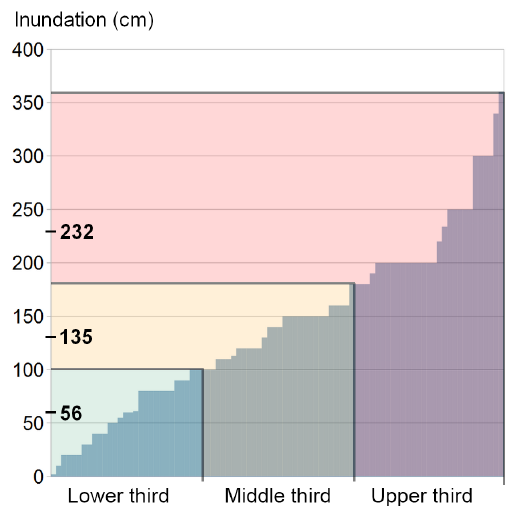
Figure 5. Deriving the local impact indicator. The recorded inun- dation depth is sorted in ascending order. By sorting, the relatively uniform distribution of the inundation values is shown, which al- lows for the general procedure. On the left, the mean values of the lower, middle, and upper third of the sorted inundation depth (56, 135, 232cm) are given, which were used to replace the exposition classes, low, medium and high. This step enables a comparable vari- able range and the derivation of an interval-scaled indicator for fur- ther